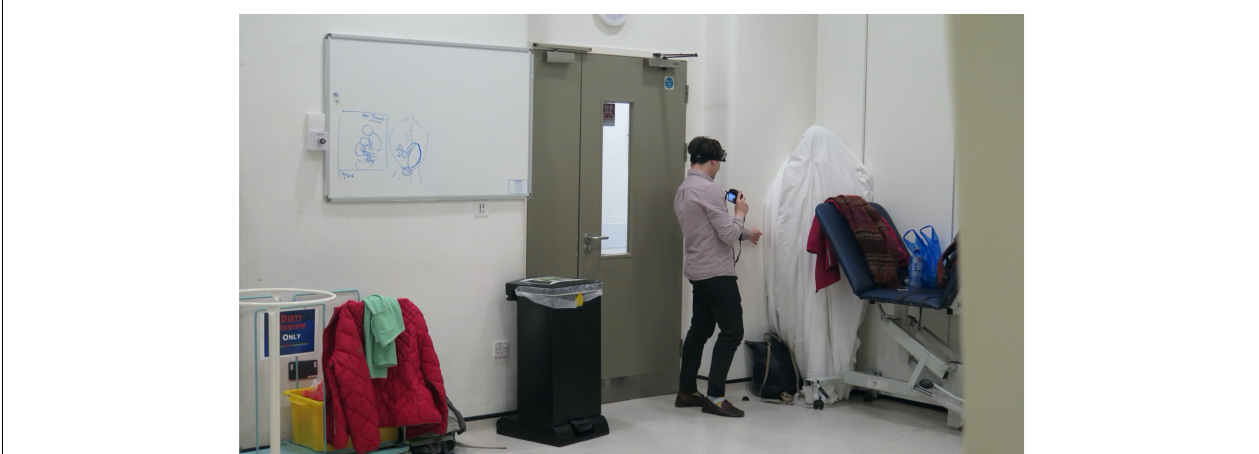
FIGURE 2 | Image of doctoral students playing hide and seek in Hiding in Plain Sight, Becky Shaw.